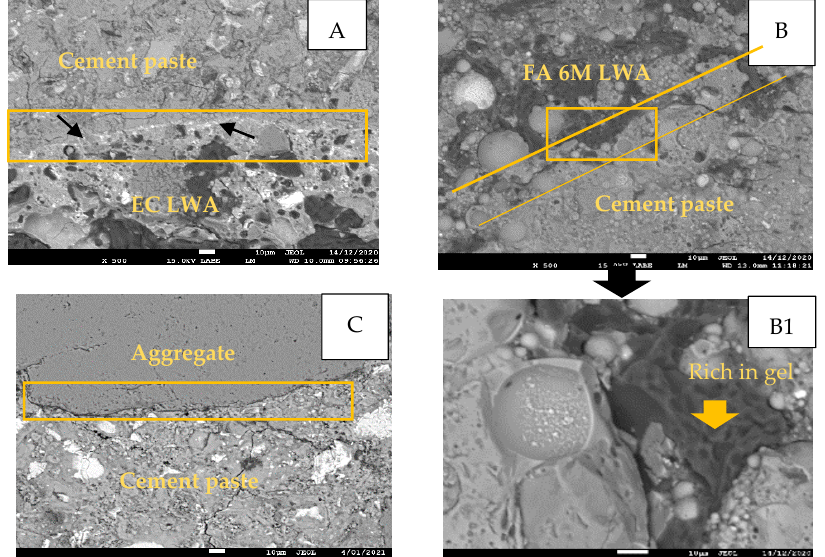
Figure 11. BSE SEM image of the Interfacial Transition Zone of around 10 µm in thickness ( A ) EC LWA; ( B ) FA 6M LWA; and ( C ) normal aggregate with cement paste. ( B1 ) magnification of selected area in ( B ) to confirm the presence of gel in the ITZ between FA LWA and cement paste. Table 4. Resume of EDS mapping analysis on the amount of Ca, Si and Al in ITZ between cement paste and aggregate.